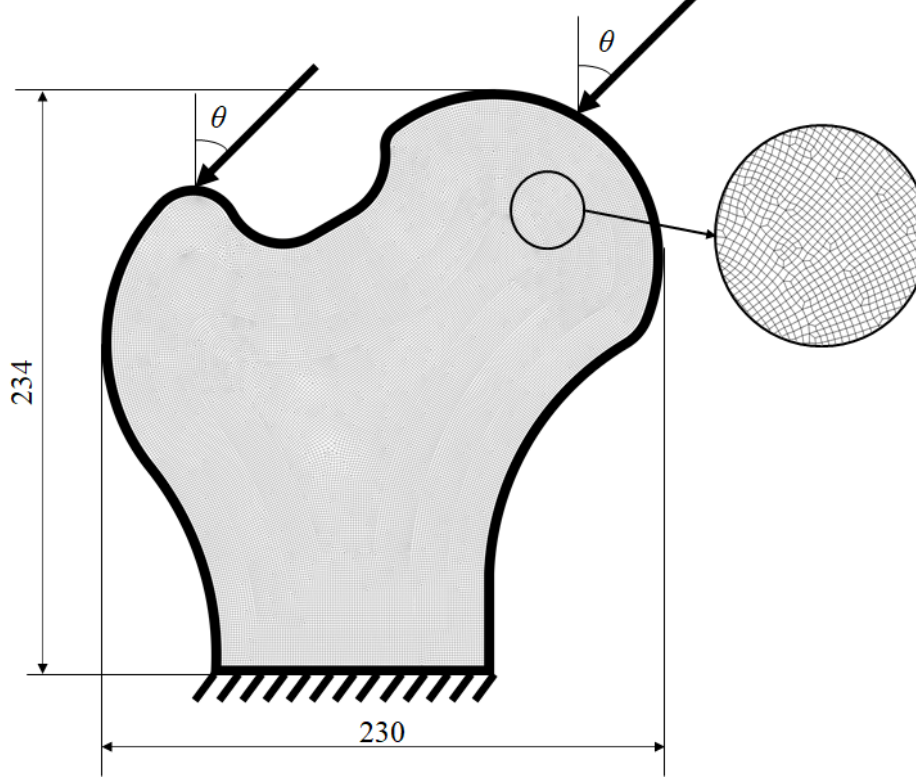
Figure 8. The optimized topologies from different meshes: ( a ) 400 × 200: c = 90.231, V f = 0.451, max ( b ) 800 × 400: c = 88.148, V f = 0.449, max c = 86.208, V f = 0.448, max